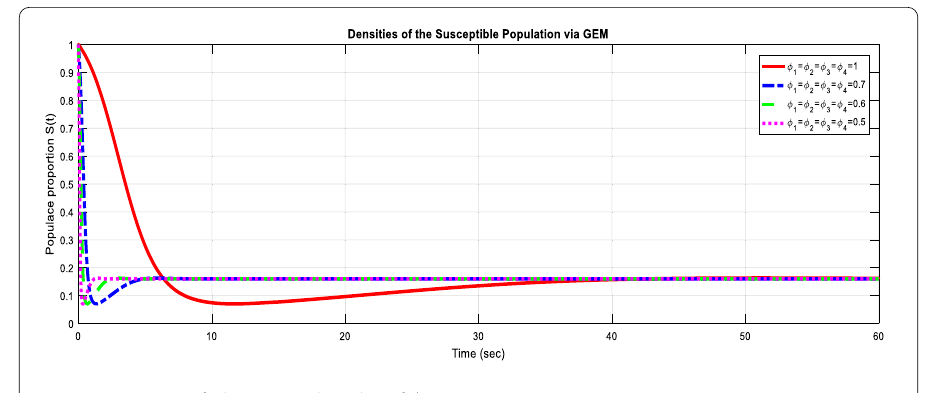
Figure 6 Dynamic of S by varying the value of φ